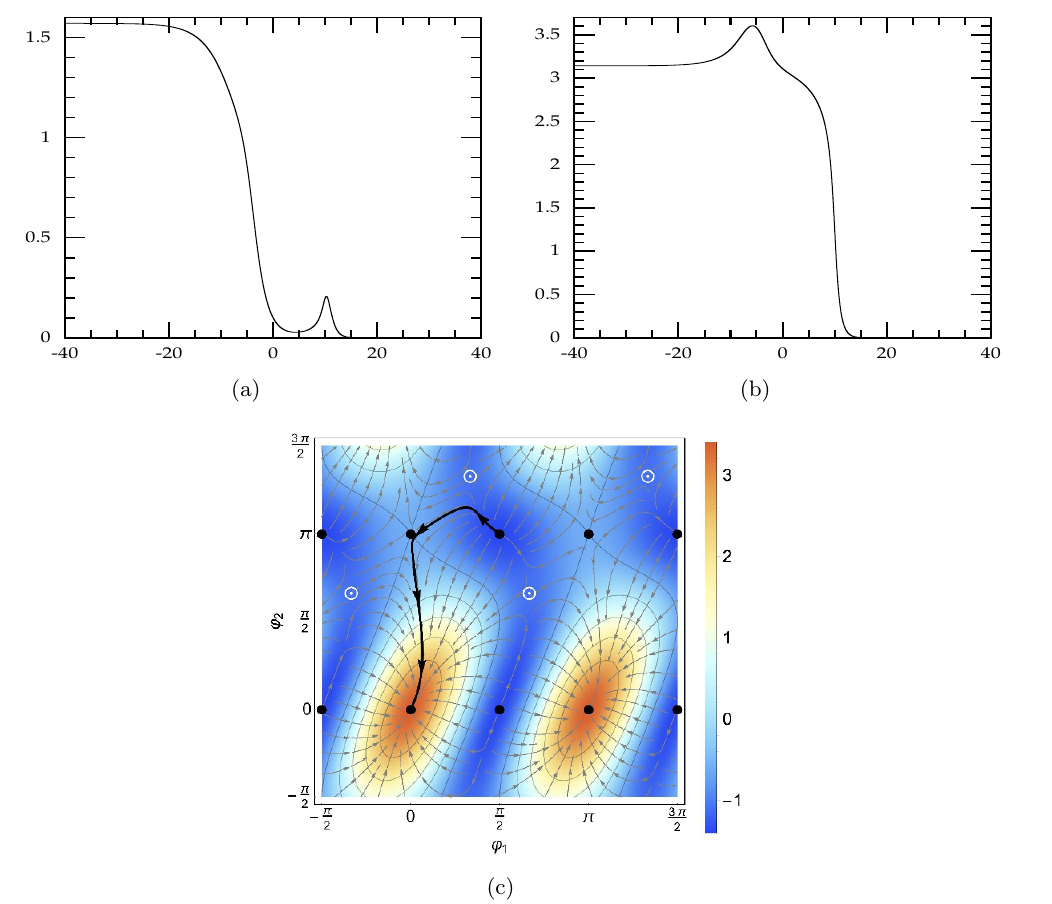
Figure 13 . SO(5) (cid:12)elds | case I; (a) ’ 1 , (b) ’ 2 and (c) ~ r (cid:17) U (cid:0) (cid:13)ow. Vacua (7.3) are denoted by dots whereas vacua (7.4) are marked by (cid:12)